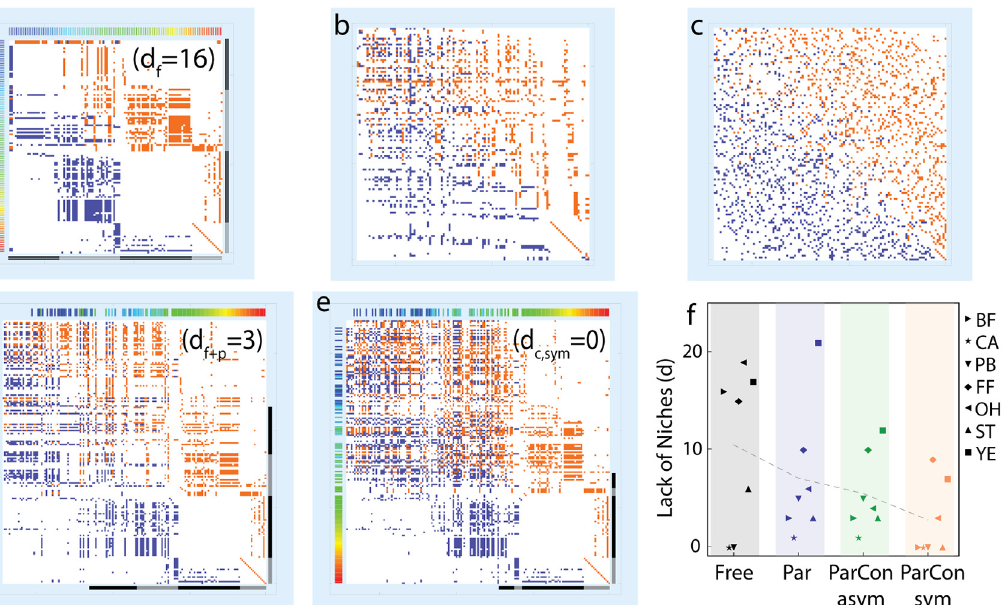
Fig 5. Comparison to existing models and data analysis. a , Bahia Falsa free-living food web, with blue and red matrix elements for predator respectively prey dependency. Trophic levels indicated by gray and black bars, whereas color coding along the left and upper edge labels chain length of free-living species (increase from red to blue shades). b , Niche model simulation of the Bahia Falsa free-living food web. c , Cascade model simulation of the Bahia Falsa free-living food web. d , As (a) but with parasites ( “ Par ” ) and with colors for free-living species carried over from (a). Remaining species are parasites. e , As (d) but additionally including symmetric concomitant links ( “ ParCon sym ” ). f , Lack of niches ( d ) for seven empirical food webs [31]. Labels mark the sub- webs of free-living species ( “ Free “ ), including also parasite links ( ” Par “ ), asymmetric ( ” ParCon asym “ ) and several symmetric concomitant links ( ” ParCon sym “ ). Dashed line connects averages in these categories. Rank deficiencies for free living ( d f ), free-living and parasite species ( d f + p ) as well as additional concomitant links ( d c , sym ) marked in (a), (d), and (e), respectively. (Analysis details and abbreviations: see Methods).